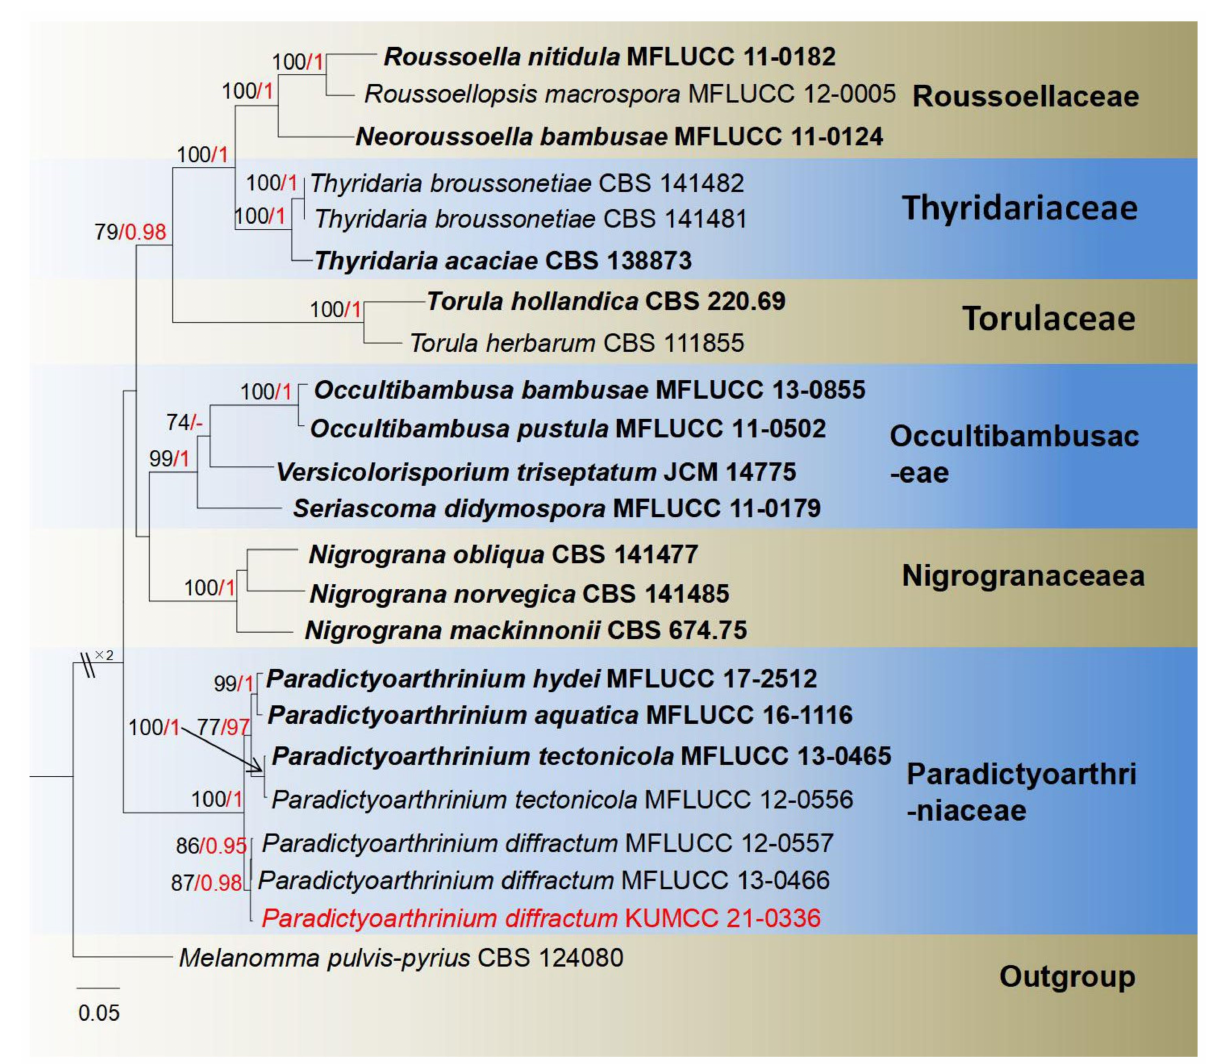
Figure 11. Phylogram generated from maximum likelihood analysis based on a combined LSU, ITS, and rpb2 sequence datasets. Related sequences were taken from Liu et al. [86]. The 23 strains are included in the combined gene analyses’ 2523 total characters, including gaps (LSU: 1–867 bp, ITS: 868–1447 bp, rpb2 : 1448–2523 bp). Tree topology of the ML analysis was similar to the BI. The matrix had distinct alignment patterns, with the final ML optimization likelihood value of − 14,675.292545 (ln). All free model parameters were estimated by RAxML model, with 1017 distinct alignment patterns and 15.66% undetermined characters or gaps. Estimated base frequencies were as follows: A = 0.251864, C = 0.243671, G = 0.279161, T = 0.225303, with substitution rates AC = 1.434366, AG = 3.862103, AT = 1.470306, CG = 0.996484, CT = 9.230078, GT = 1.000000. The gamma distribution shape parameter alpha = 0.697593, and the Tree-Length = 1.990250. The final average standard deviation of split frequencies at the end of total MCMC generations was calculated as 0.008418 in BI analysis. The species determined in this study are indicated in red. Bootstrap values greater than 60% (ML, left) and Bayesian posterior probabilities (BI, right) greater than 0.95 are given at the nodes; hyphens (-) represent values less than 60% in ML/0.95 in